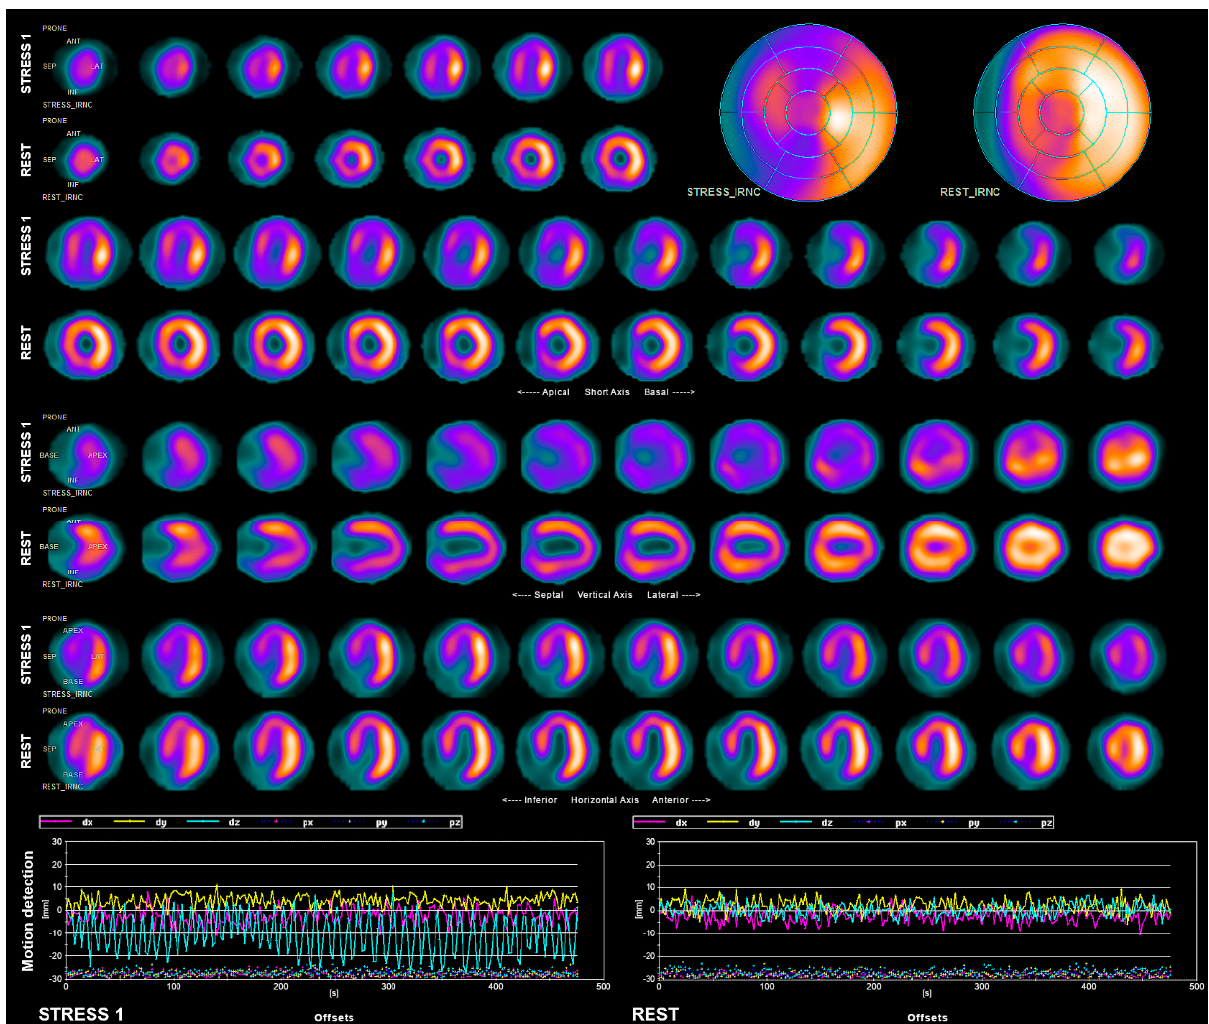
Figure 1. 61-year-old male patient, a sailor, was referred for myocardial perfusion scintigraphy (MPS) by an occupational physician, in order to exclude coronary artery disease (CAD). Patient had a history of complete left bundle branch block (LBBB) that rendered a treadmill stress test (used as routine screening for job qualification) non-diagnostic. Apart from LBBB, patient had no history of heart diseases, diabetes, or uncontrolled hypertension and had good stress tolerance, with no symptoms of angina. Transthoracic echocardiogram revealed no abnormalities, apart from contraction patterns typical for LBBB. MPS was performed on GE Healthcare camera Discovery NM 530c, equipped with solid state cadmium-zinc- telluride (CZT) detectors, in a two-day rest/stress protocol, using 3 MBq/kg (0.08 mCi/kg) technetium-labeled Sestamibi (99mTc-MIBI) administered intravenously on each day. Image acquisition was performed in prone position for 8 minutes, 60 minutes after radiopharmaceutical administration. Stress test was carried out according to Bruce protocol. Patient completed rate of 136 bpm, which was 85% of an age-predicted maximum rate. Blood pressure incremented normally in response